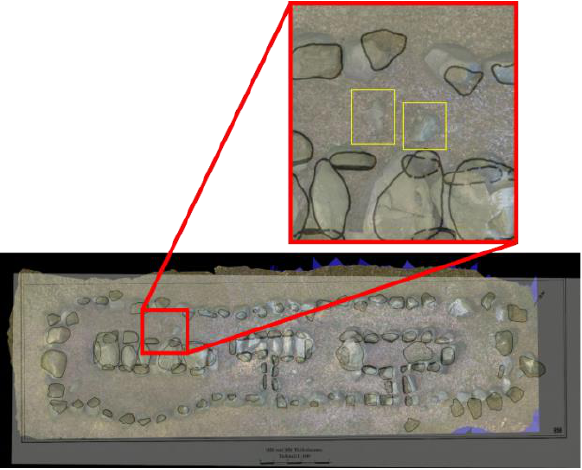
Figure 7: Graphic superimposition of recent true orthophoto with historical excavation plan (bottom). Missing stones in historical plan highlighted in yellow, visible in true